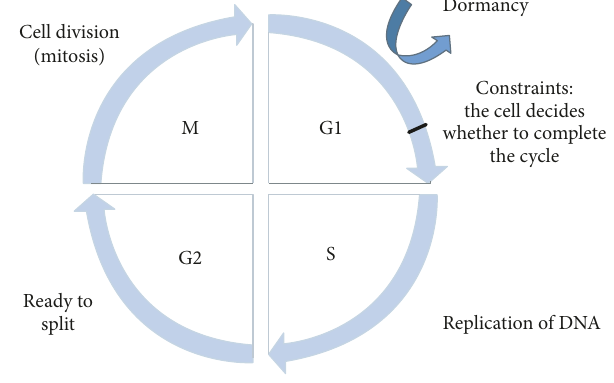
Figure 2: Cell division